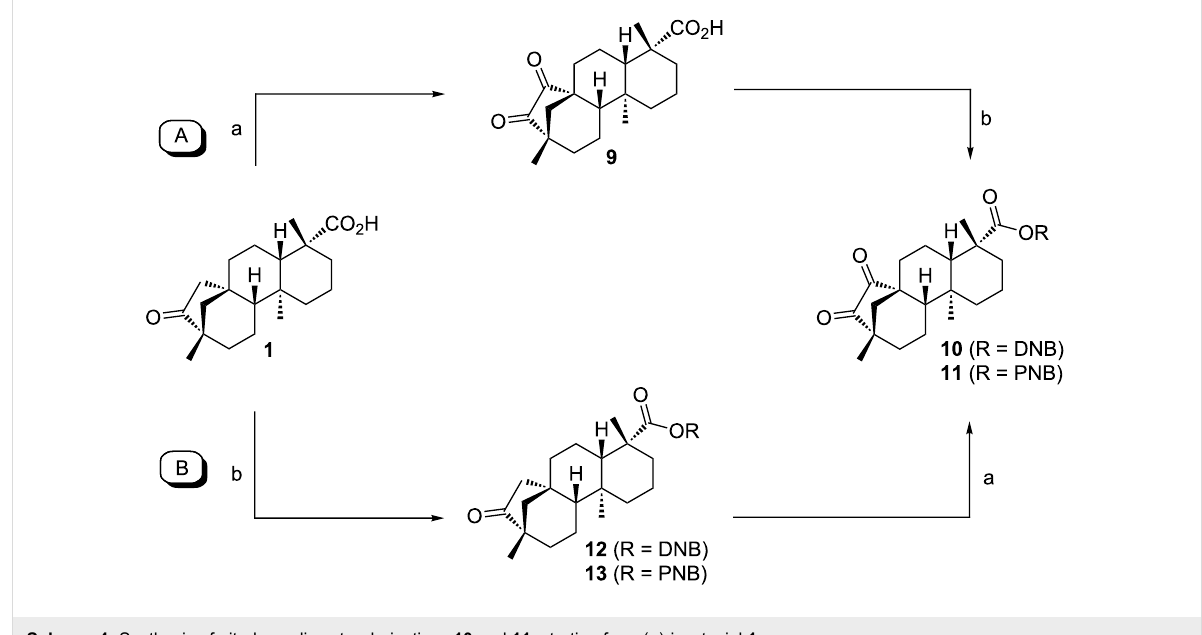
Table 1: Oxidation and esterification sequence of 1 . R = Reaction conditions Yield Overall yield a + b DNB a: SeO 2 , xylenes, 145 °C, 2 d 9 : 80%